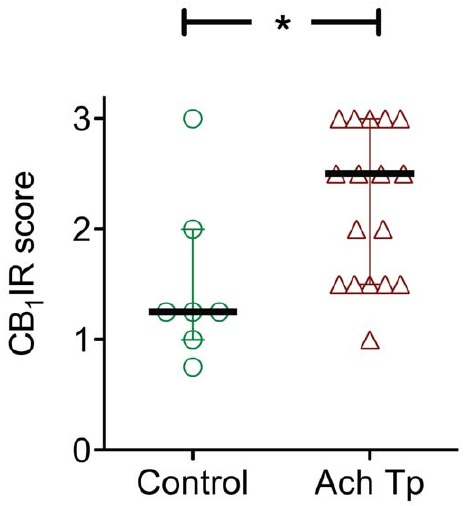
Figure 4. CB 1 IR scores for biopsy samples from controls and patients with Achilles tendinopathy. Shown is a box and whiskers plot of CB 1 immunoreactivity in pain-free Achilles tendons (controls, n=7) vs. tendons from patients with Achilles tendinopathy (n=17). *p= , 0.05, two-tailed Mann-Whitney U test. Values are mean of the scoring made by the two investigators.